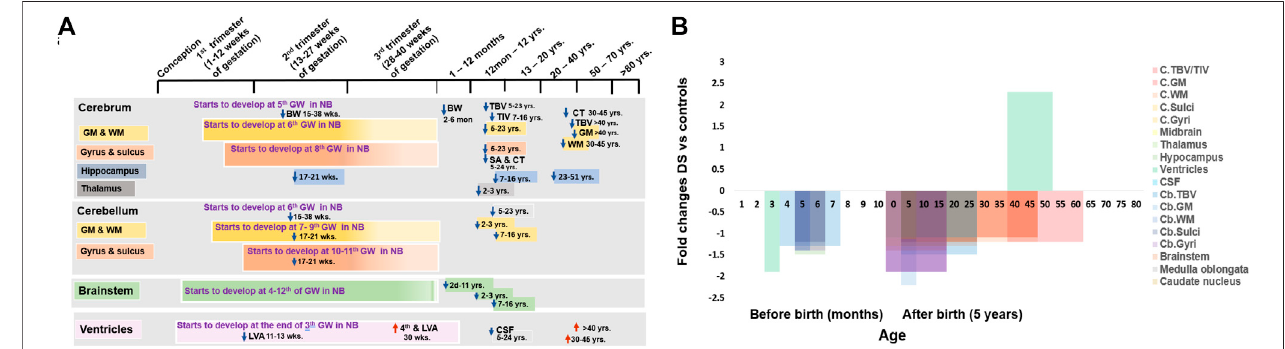
FIGURE 1 | Anatomical changes in human Down syndrome brains. (A) Time line of major brain structures during development in normal (color boxes) and Down syndrome (DS, color arrows). (B) Fold changes of various brain structure volumes or sizes in DS vs. normal controls. Mean change data is extracted from available literature as shown in Table 1 . NB = normal brain; DS = Down syndrome; ↑ = increase; ↓ = decrease; GW = gestational week; GM = Gray matter; WM = White matter; TBV = total brain volume; TIV = total intracranial volume; LVA = lateral ventricular area; CPA = choroid plexus area; CSF = cerebrospinal fl uid; C = cerebral; Cb =